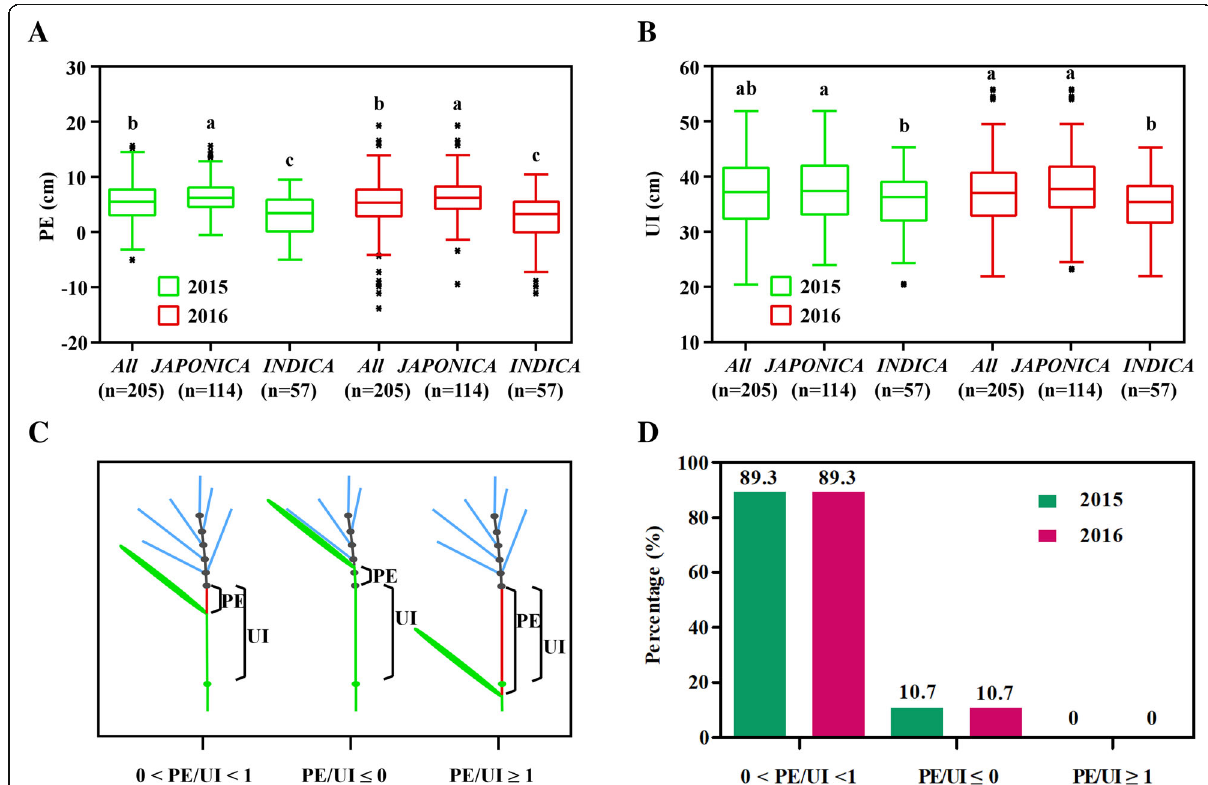
Fig. 1 Phenotypic distribution in the RDP1 in 2015 and 2016. a , b Box plot of the phenotypic variation of PE and UI within the All , JAPONICA and INDICA groups. The horizontal lines represent the median values, box edges represent upper and lower quantiles, and whiskers are 1.5 times the quantile of the data. Outliers are shown as open dots. n represents the number of genotypes, and small letters above error bars indicate significant differences between subpopulations (LSD, P < 0.05). c Three pattern diagrams between PE and UI. 0 < PE/UI < 1 represents flag leaf overlapping a part of PE, PE/UI ≤ 0 represents flag leaf enclosing the panicle partly or fully, and PE/UI ≤ 0 represents flag leaf under the node of UI. d Analysis of frequency distribution for the three models between PE and